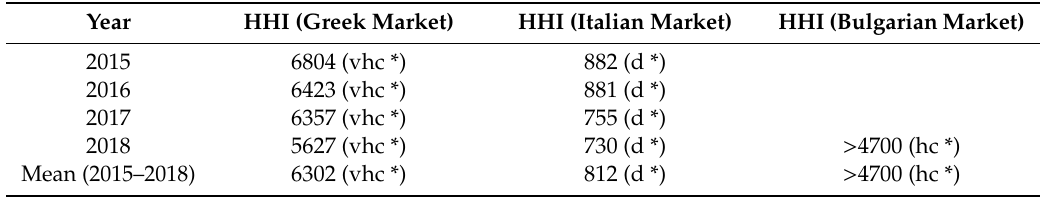
Table 1. Herfindahl–Hirschman index (HHI) in the power generation ‘’market’’ of the analyzed electricity markets for 2015-2018 as depicted in the national reports of regulators sent to the European Commission (EC).